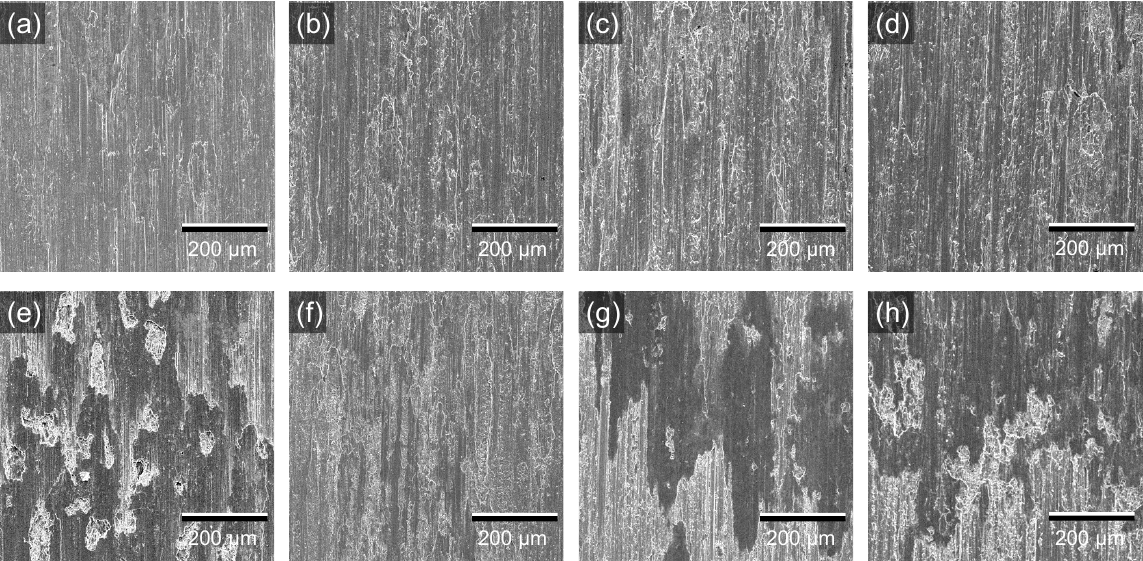
Figure 6. Exposed metal surfaces after grinding: ( a ) Ti; ( b ) 6Nb4Cu; ( c ) 18Nb2Cu; ( d ) 24Nb1Cu at 750 m/min; ( e ) Ti; ( f ) 6Nb4Cu; ( g ) 18Nb2Cu; ( h ) 24Nb1Cu at 1500 m/min. The electron micrographs of the wheel surfaces after grinding are depicted in Figure 7.